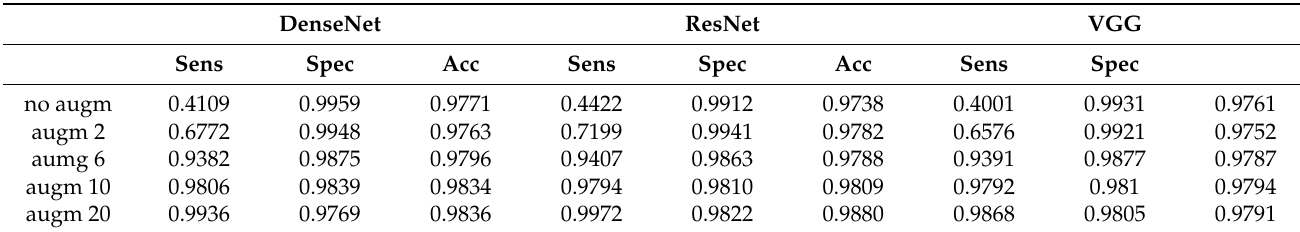
Table 4. Results for the sick fir class for three DL networks and five data augmentation scenarios. Values for the LR obtaining best specificity are shown for all augmentation scenarios. augm “n” stands for a data augmentation scenario where “n” images are created for each existing sick fir